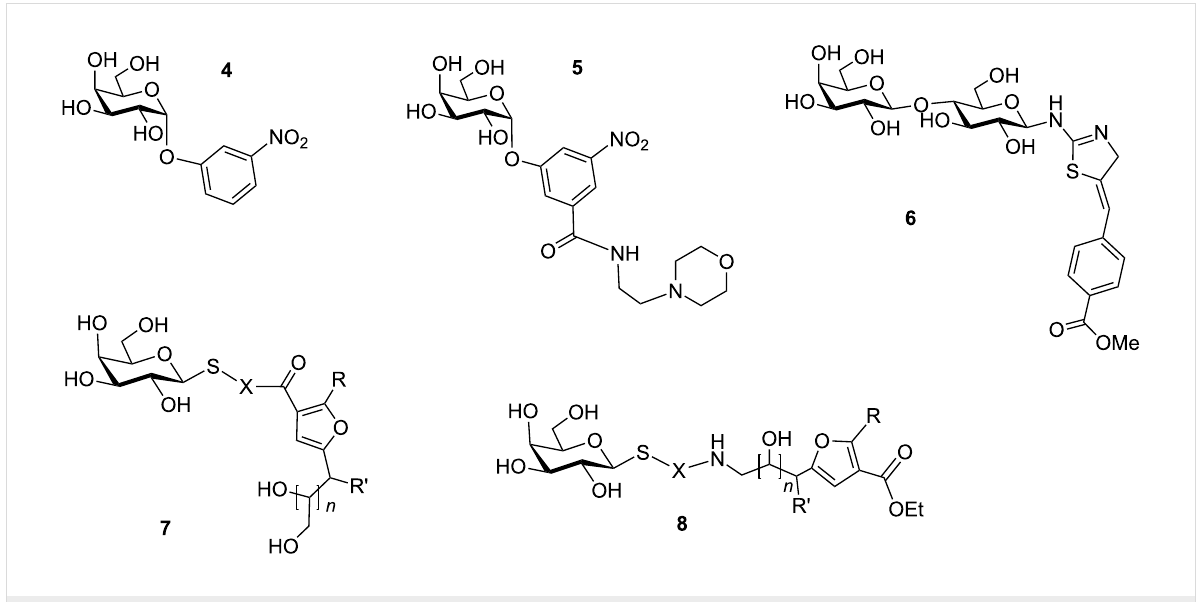
Figure 4: Structure of monomeric ligands. X = amino acid residues, aminoalkyl, 1,2,3 triazoles; n = 1, 2; R = H, Me, R' = OH, NHAc.